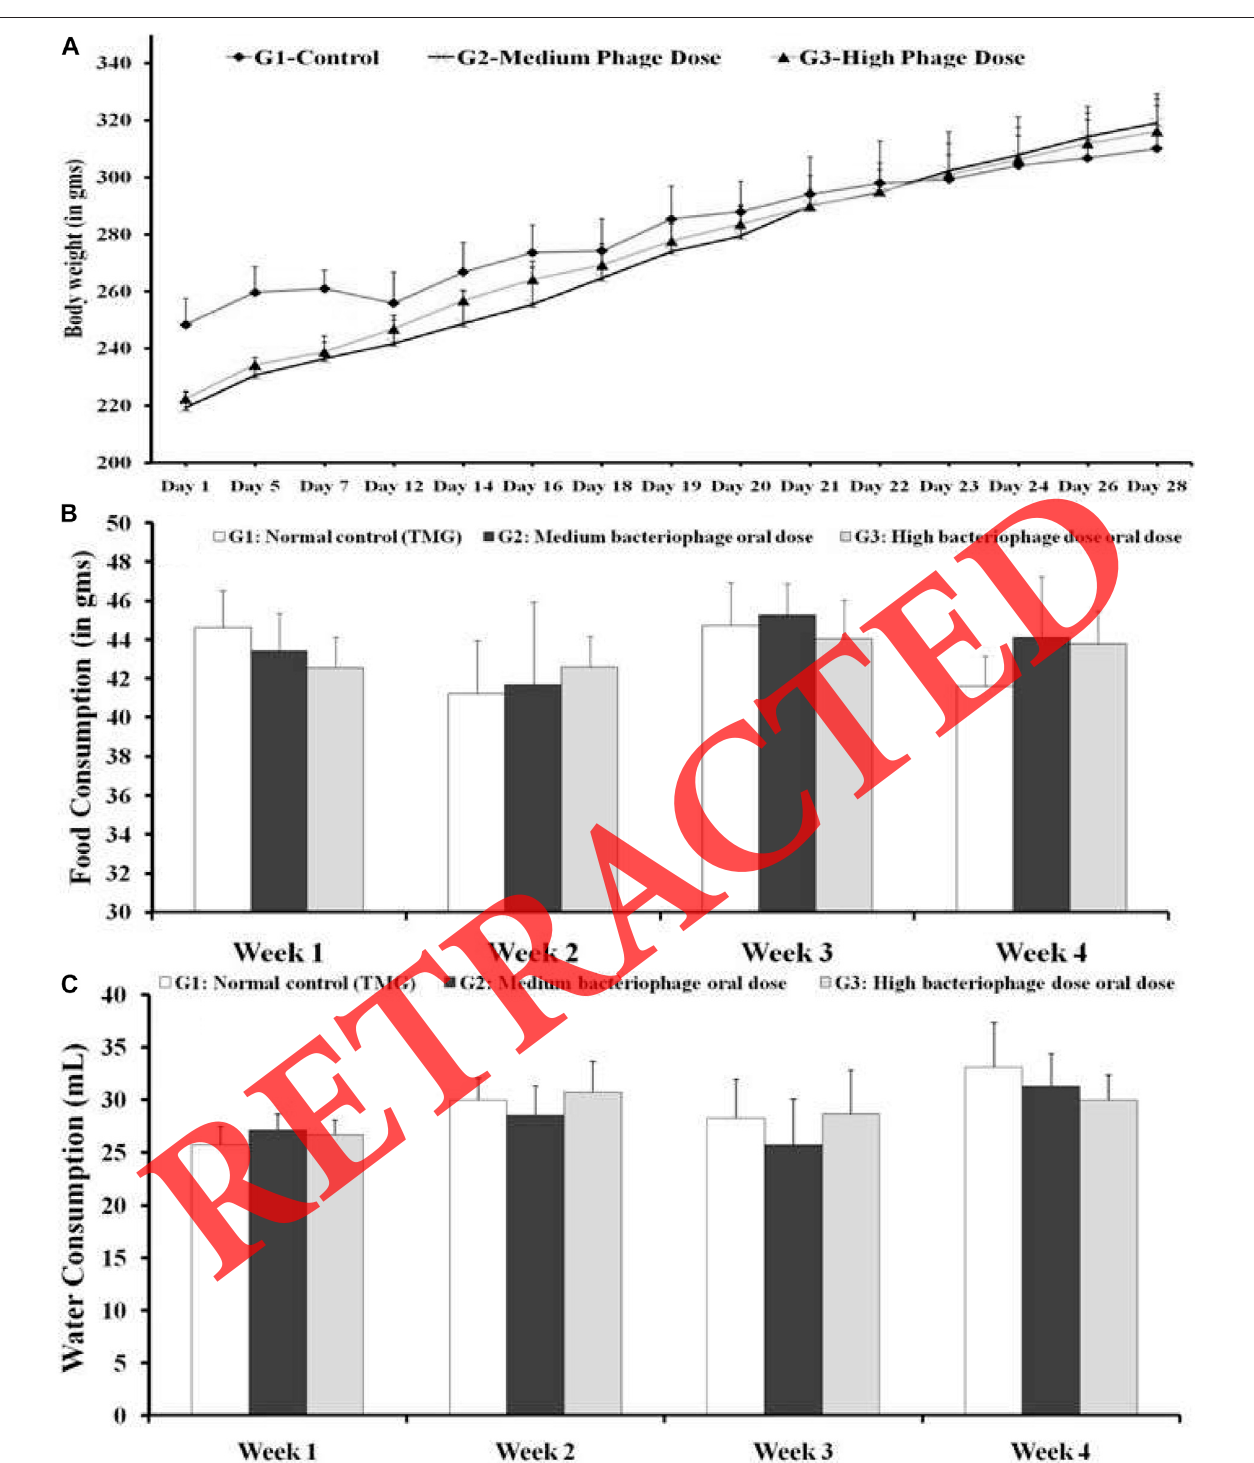
FIGURE 2| (A) Body weights analysis (B) Average daily feedconsumption and (C) Water consumption(in ml). G1: Control group animalsreceived TMG (Tris-HCl, magnesium sulfate, gelatin pH 7.4) buffer; G2: Animals received oral administration of the medium dose of bacteriophages (10 15 PFU/ml); and G3: High oral dose of bacteriophages (10 20 PFU/ml). All the values are presented as mean ± SEM ( n (cid:2) 6). No signi fi cant difference could be found among the different groups ( p > 0.05).